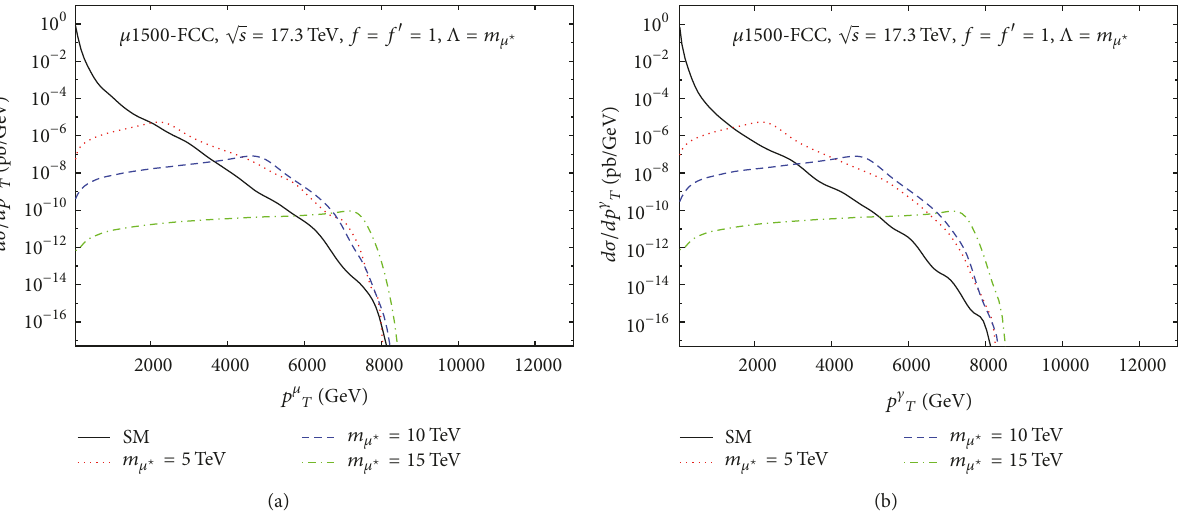
Figure 8: Muon (a) and photon (b) 𝑝 𝑇 distributions for the 𝜇1500 -FCC.